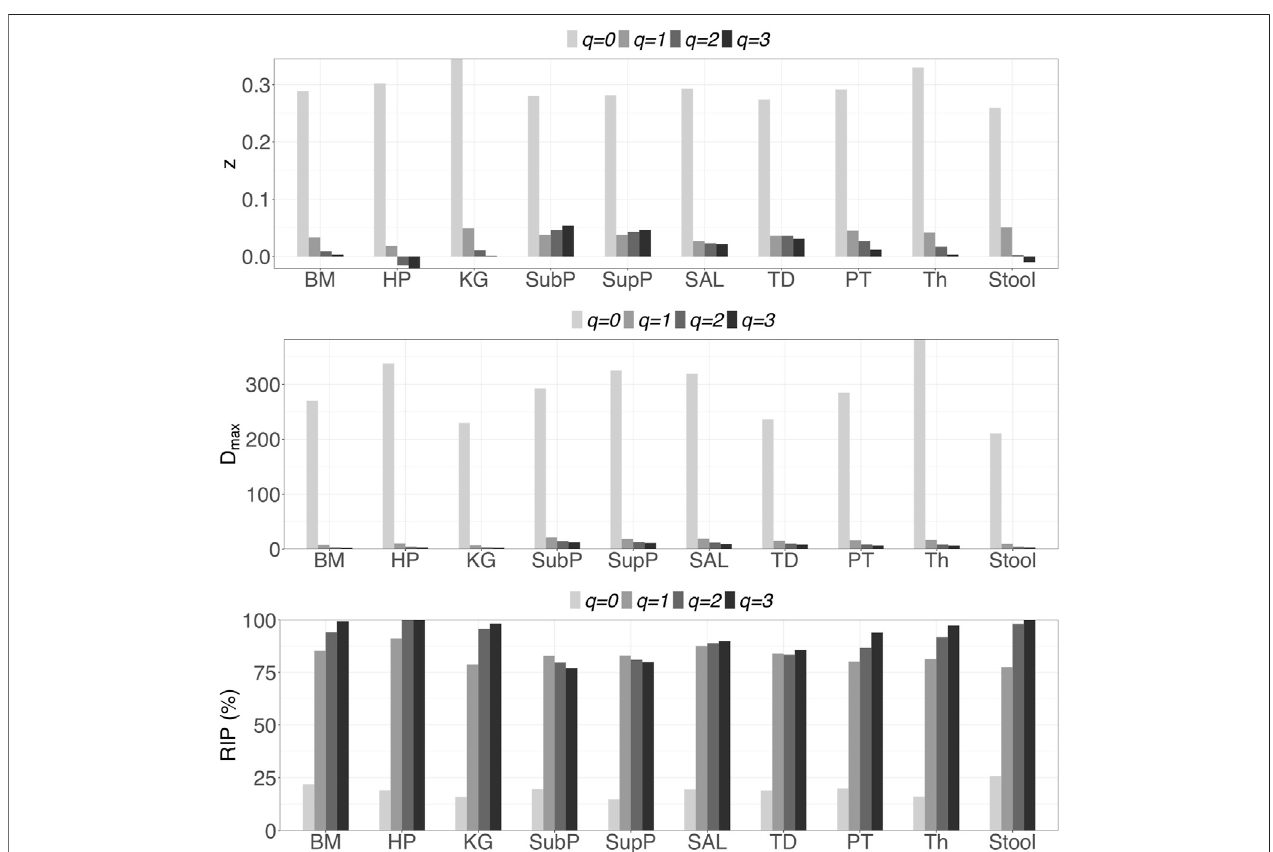
FIGURE 1 | Graphs of the three important pro fi les from inter-individual DAR models for each of the 10 DT microbiome sites at genus taxon level, including DAR pro fi les ( z-q patterns), MAD pro fi les ( D max - q patterns), and RIP pro fi les ( RIP - q patterns). Bar color-depth indicates diversity order. The x -axis shows the DT sites: buccal mucosa (BM), keratinized gingiva (KG), hard palate (HP), throat (Th), palatine tonsils (PT), tongue dorsum (TD) and saliva (Sal), supraginval (SupP), subgingival plaques (SubP), and stool (Stool).